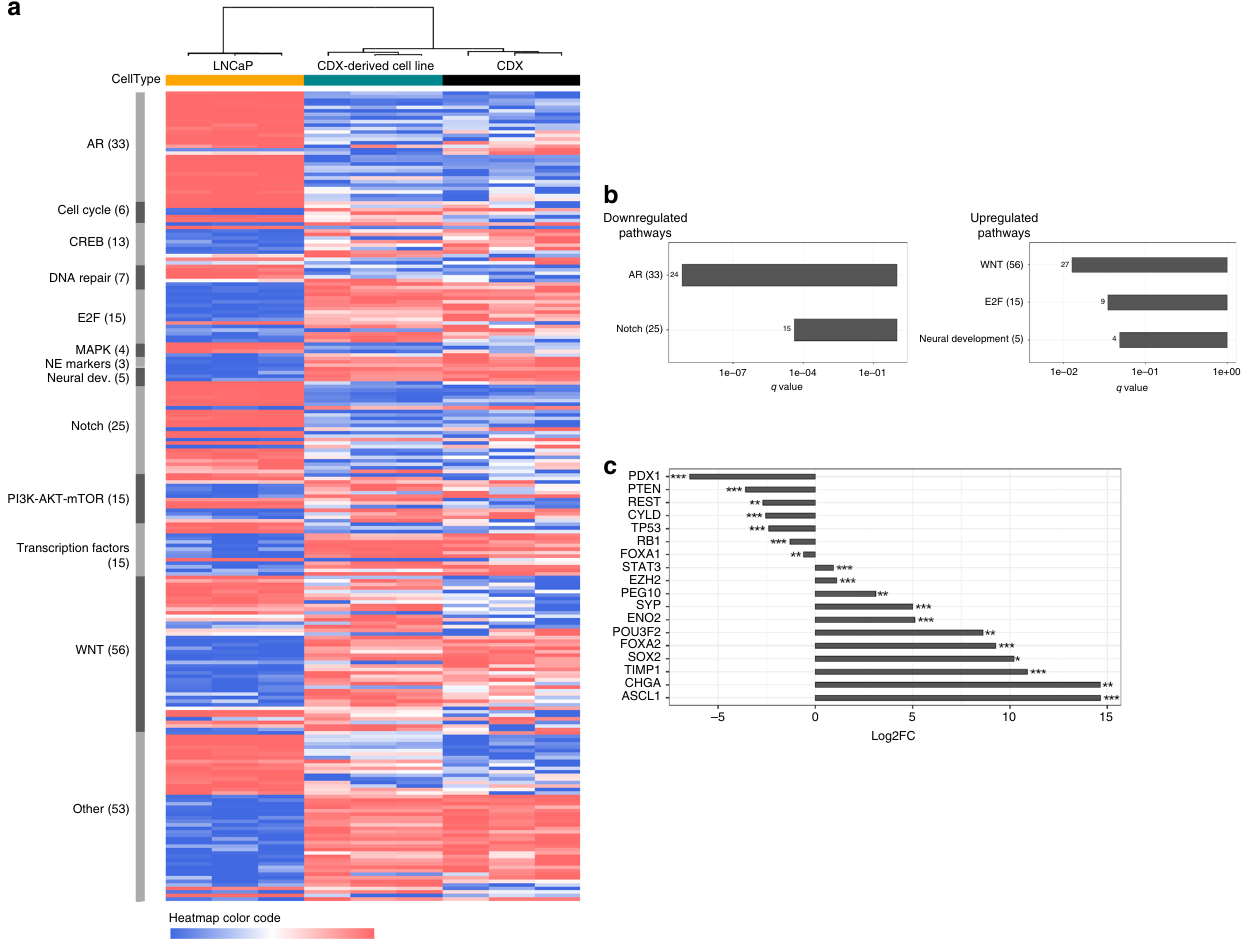
Fig. 2 Transcriptional pro fi le of the CDX and the CDX-derived cell line. a Unsupervised hierarchical clustering of transcriptional pro fi les of the LNCaP cell line and the CDX and CDX-derived cell line. The rows show the normalized expression of 250 functional genes that are relevant for CRPC-NE progression and/or NED signaling pathways and signi fi cantly deregulated (CPM ≥ 2 in at least three samples). The number of genes analyzed per pathway is indicated in parentheses ( b ). Results of the supervised analysis of signaling pathways involved in CRPC-NE progression and/or NED that are differentially expressed between LNCaP cells and the CDX. Histogram bars represent downregulated or upregulated pathways according to their q value ( ≤ 0.1). The number of genes signi fi cantly deregulated in each pathway is mentioned. c Results of the supervised analysis of the main genes involved in CRPC-NE progression and/or NED that are differentially expressed between LNCaP cells and the CDX. Histogram bars represent underexpressed and overexpressed genes according to the fold change. * q value < 0.1, ** q value < 0.01, *** q value <